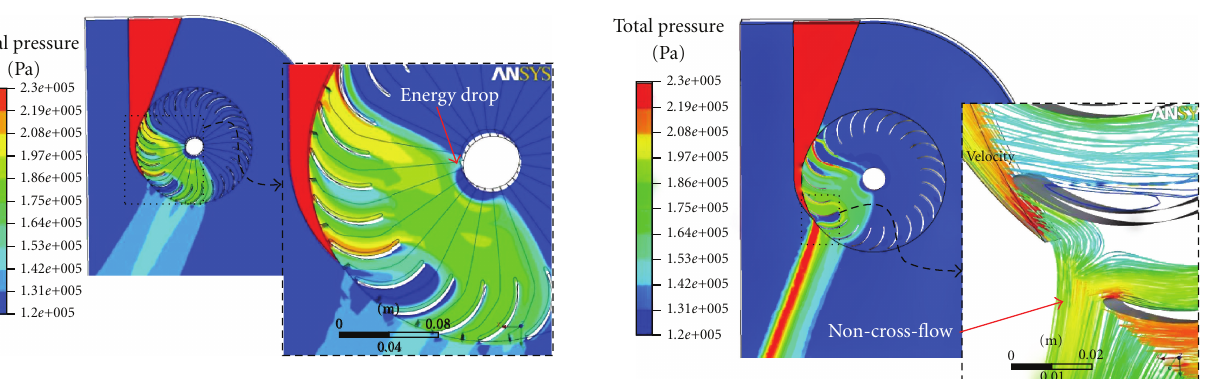
Figure 15: Total pressure contour at midspan of domain nozzle- runner-casing for runner speed 1200 rpm.